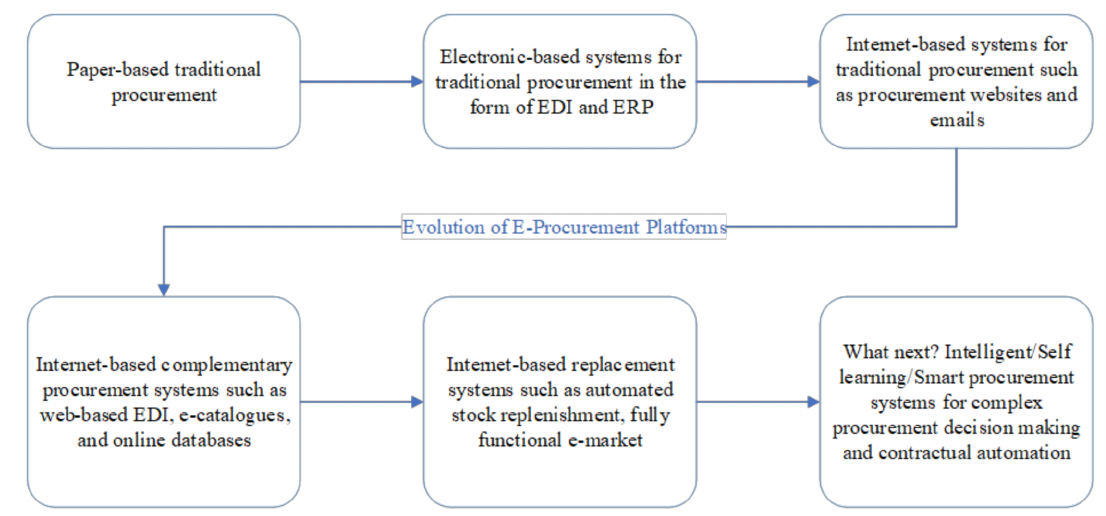
Figure 1. Evolution of EP (adapted from The United Nations Global Marketplace (UNAM)